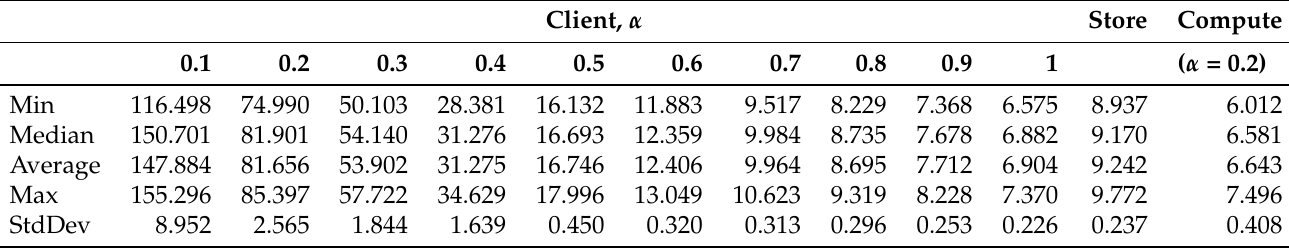
Table 2. Overview of obtained service latency T results for YOLOv2 performed on-device (with varying degrees α of server computation resource), store-and-forward networking with server-side processing, and compute-and-forward with α = 0.2 client-side processing up to layer 8 of YOLOv2 and remainder processing server-side. All results are in seconds.